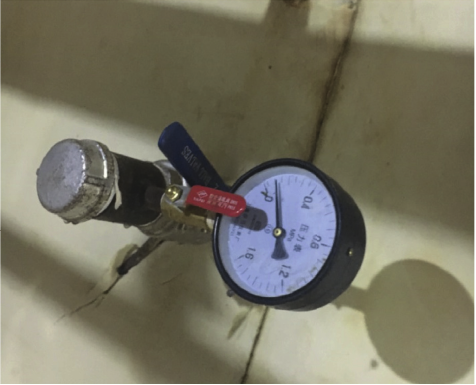
Figure 13: Pressure gauge in the pressure relief hole.